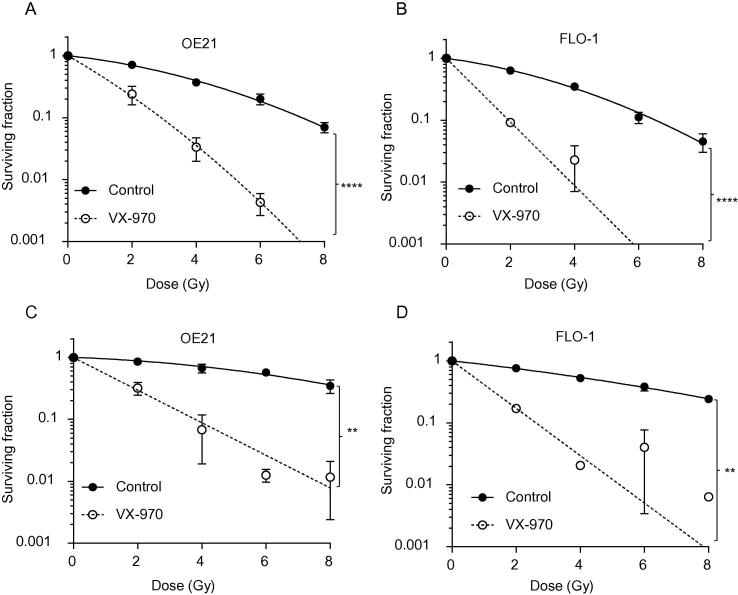
VX-970 treatment increases the sensitivity of esophageal cancer cells to radiation in normoxic and hypoxic conditions. OE21 (A) and FLO-1 (B) cells were treated with VX-970 (50 nM) and then irradiated with the doses indicated followed by a colony survival assay. This experiment was then repeated in hypoxic conditions (<0.1% O2) for OE21 (C) and FLO-1 (D) cells. Results shown are mean ± SEM (n = 3). Significance: Two-way ANOVA test, **P < 0.01,****P < 0.0001.